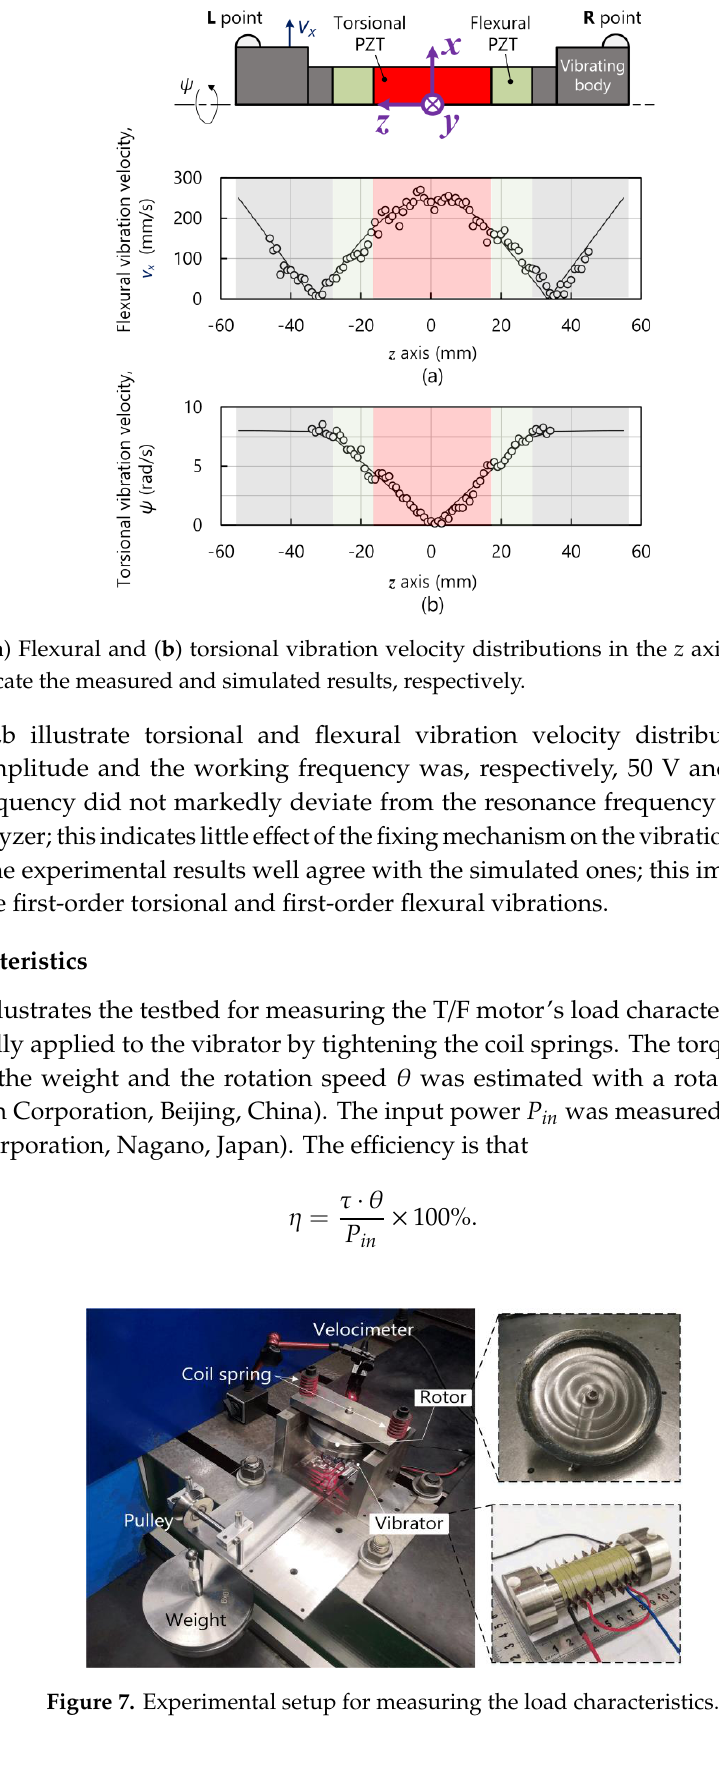
Figure 8. No-load rotation speed as a function of the phase shift of the voltages applied to torsional and flexural vibrations. The voltages applied to the flexural and torsional PZT disks have the phase shift φ . Figure 9a–c plot the variations in rotation speed, output power, and efficiency versus torque, respectively. The working frequency and the preload were set to 4.678 kHz and 600 N, respectively. The working frequency was slightly smaller than the resonance frequency dominantly because the vibration loss and the PZT’s elastic compliance become larger with increasing voltage [32,33]. When the voltage had the zero-to-peak amplitude of 250 V, the motor yielded the maximal rotation speed of 125 r/min and the torque of 4.3 Nm. Meanwhile, the maximal output power and the maximal efficiency were, respectively, 16.9 W and 10.5%. At 200 V, the no-load rotation speed decreased to 97 r/min. The efficiency was <5% probably because the frictional loss became larger.